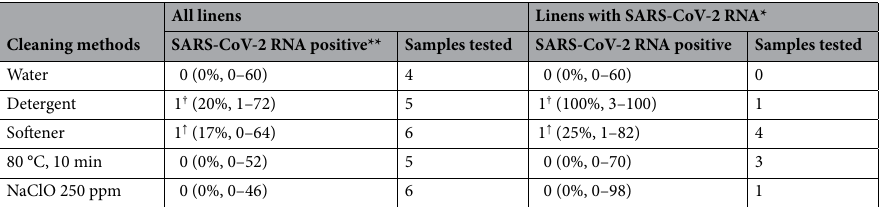
Table 3. SARS-CoV-2 RNA test results of rinse water after washing/disinfection. *Linens in which SARS- CoV-2 RNA was detected before washing or disinfection. **The number of positive samples (percentage of positive samples, 95% confidence intervals for the percentages). † Cycle threshold value = 40. The viral isolation result was negative. ↑ Cycle threshold value = 37. The viral isolation result was negative.